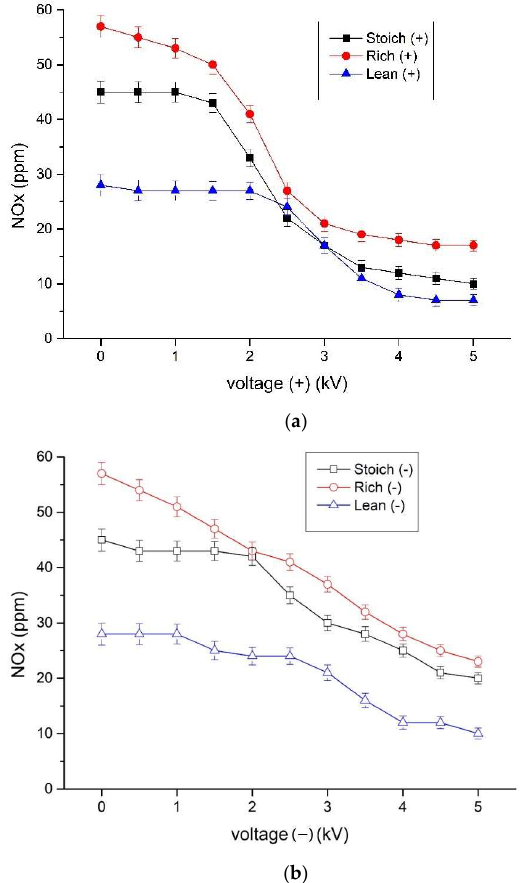
Figure 8. NO x formation: ( a ) with positive voltage; ( b ) with negative voltage.